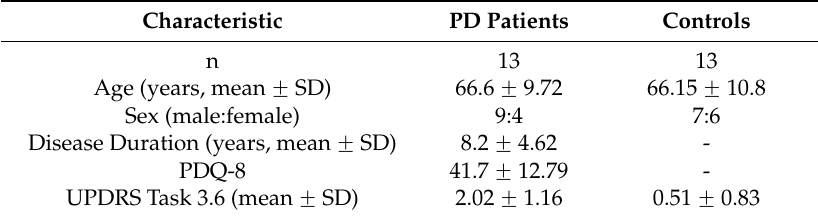
Table 1. Study Table 1. Study population.